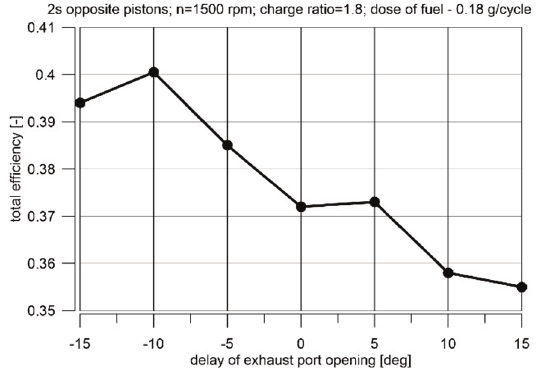
Fig. 15. Variation of engine total efficiency in dependence of delay of exhaust port close